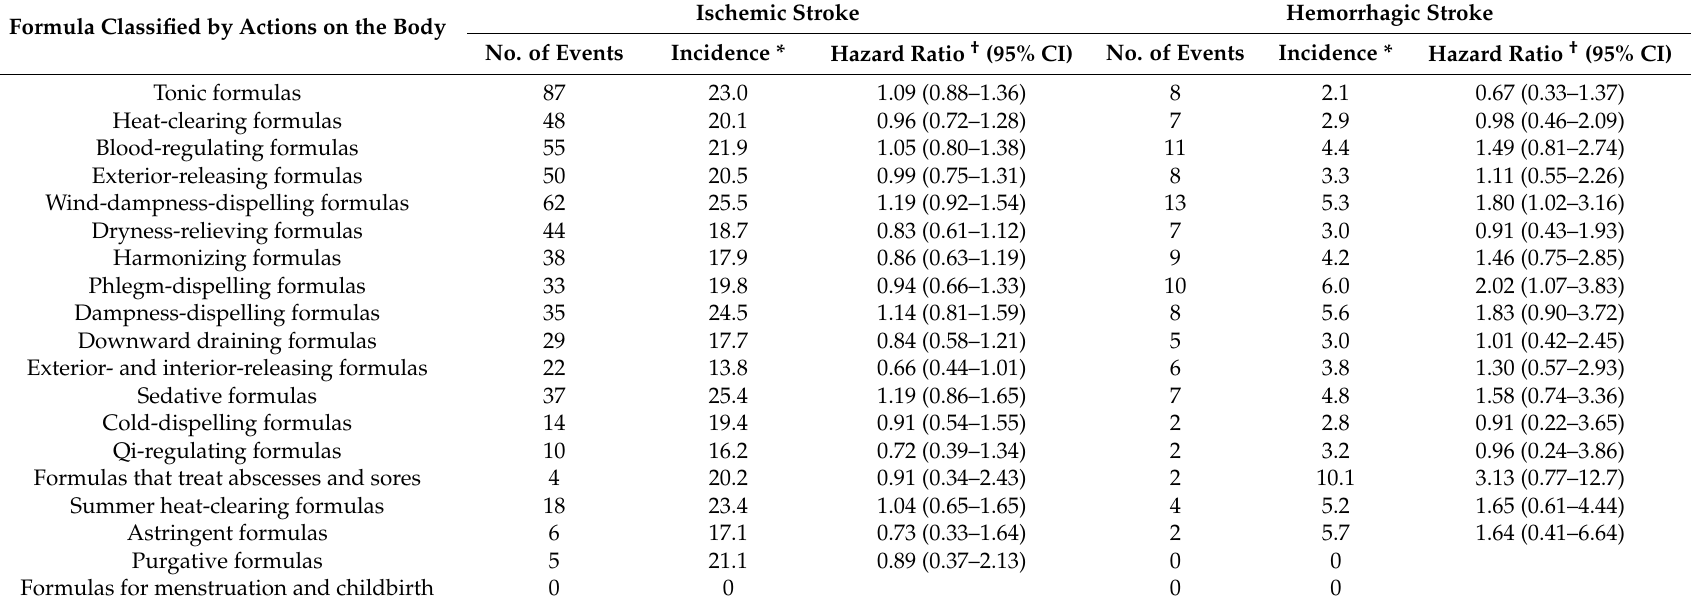
Table 4. Adjusted hazard ratios of stroke in relation to various classes of prescribed Chinese herbal